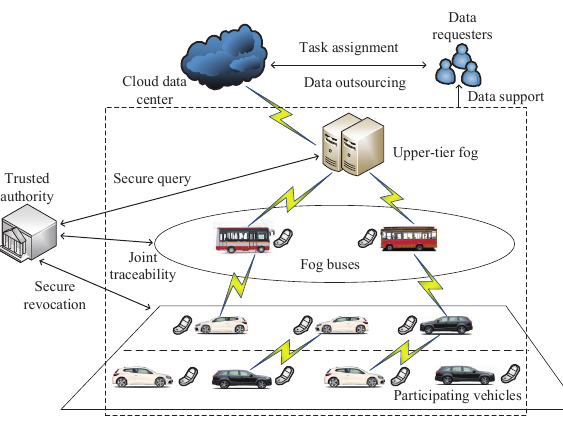
Figure 14. The architecture of the synthetic vehicle crowdsensing scheme.